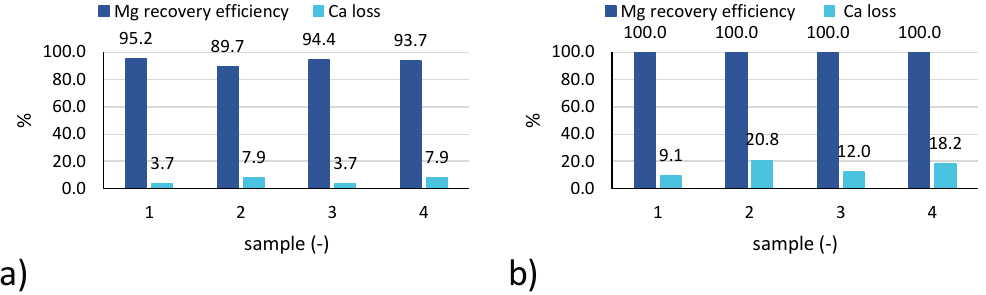
Figure 6. Magnesium recovery efficiency and calcium loss for 4 samples collected during: ( a ) test 3; ( b ) test 6.